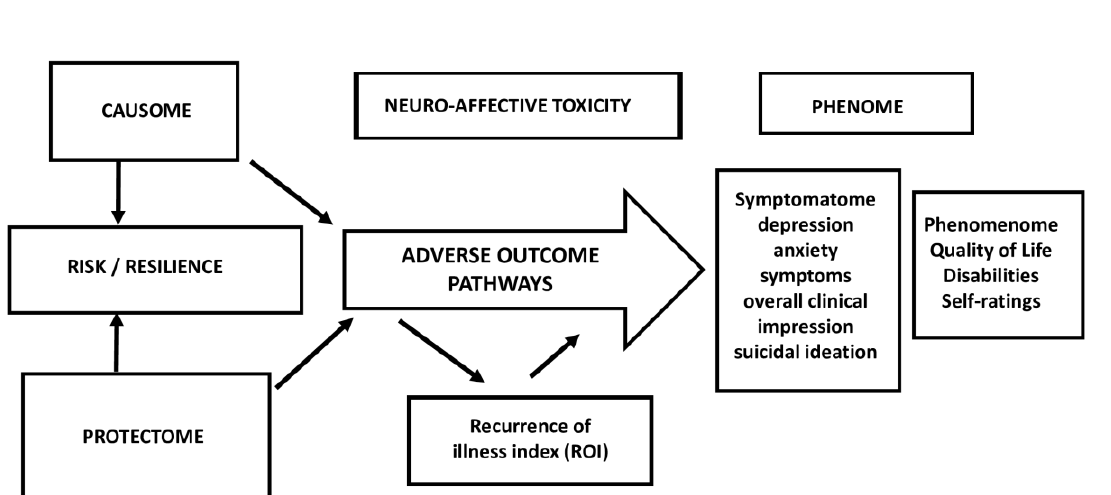
Figure 4. A knowledge-based causal framework of depression based on causal reasoning and current state-of-the-art research that describes the causal relationships between the various components of clinical depression.